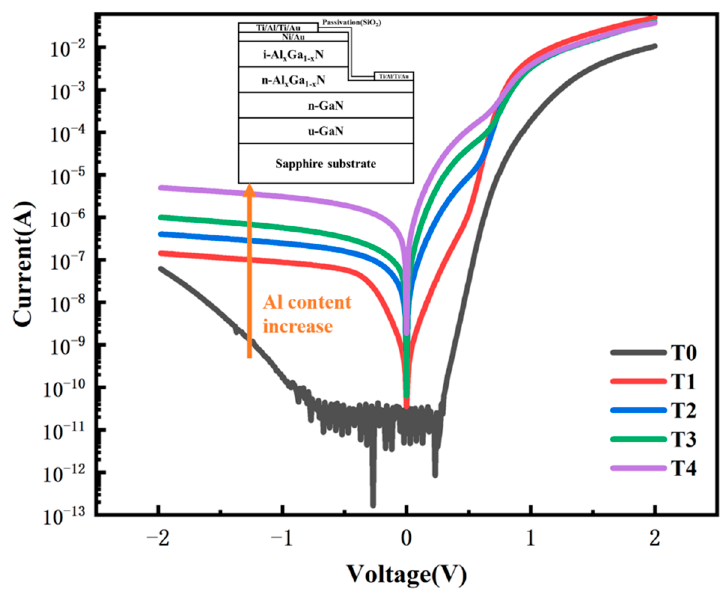
Figure 1. I–V curves of Al x Ga 1-x N Schottky barrier ultraviolet photodetector samples T0–T4.Tthe schematic diagram of the Schottky diode devices is in the inset.